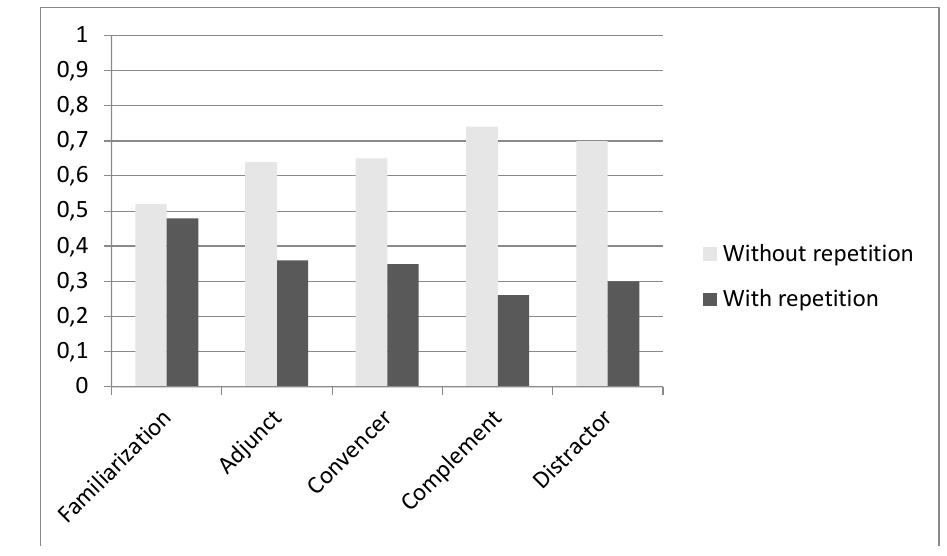
Figure 10 . Proportion of repetition by sentence type